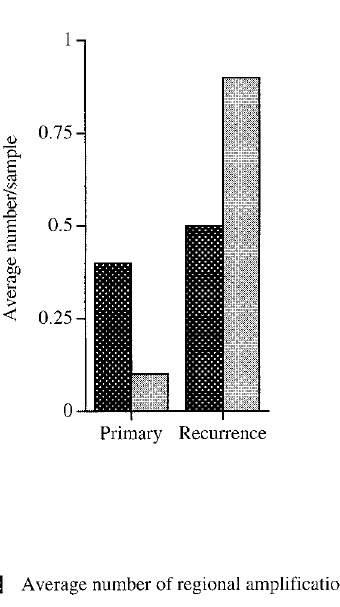
Fig. 5. CGH data from primary carcinomas and local recurren- cies. Average number of regional amplification (ANRA) and av- erage number of high copy number gains of whole chromo- some/chromosome arms in breast carcinomas from patients with long-term